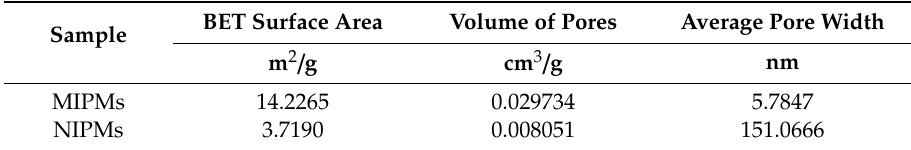
Table 1. Summary of the critical information obtained from the Brunauer–Emmett–Teller (BET) measurements, including BET surface area, the volume of pores, and average pore